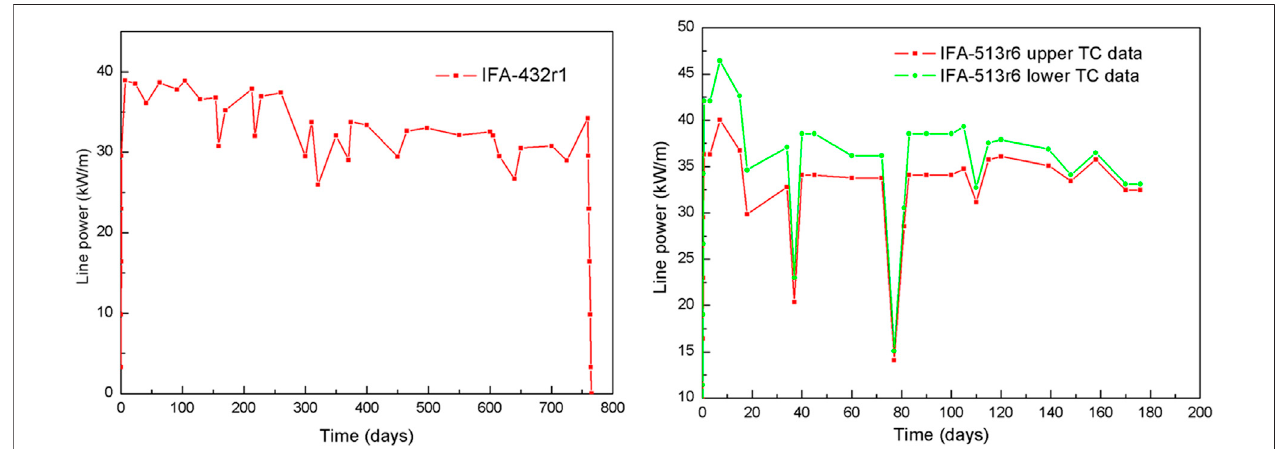
FIGURE 5 | Variation of IFA-432r1 and IFA-513r6 power with time.